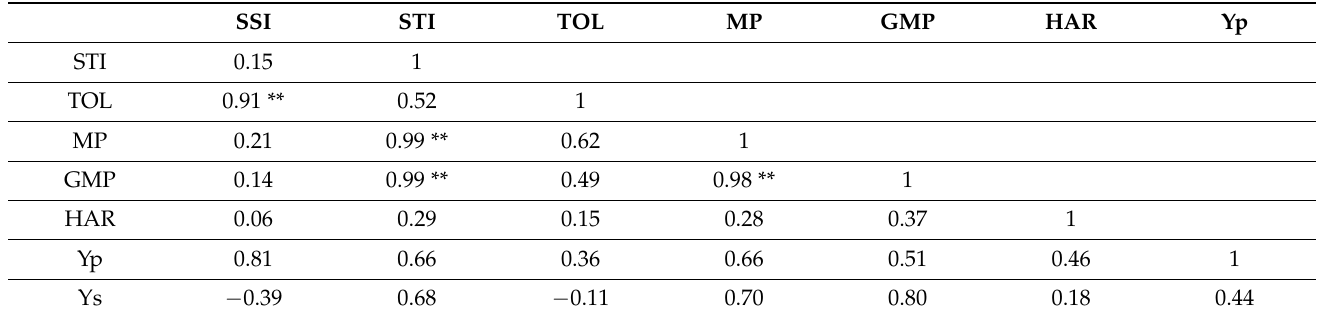
Table 6. Correlation between tolerance index and performance under stress conditions in the flower- ing